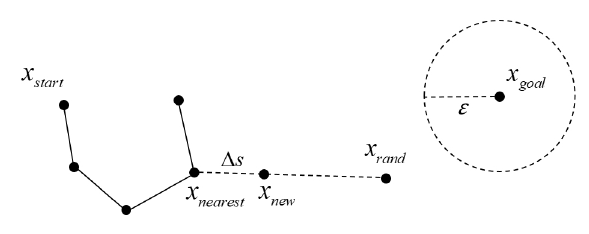
Figure 1. Illustration of the sample and extension mechanism of the RRT